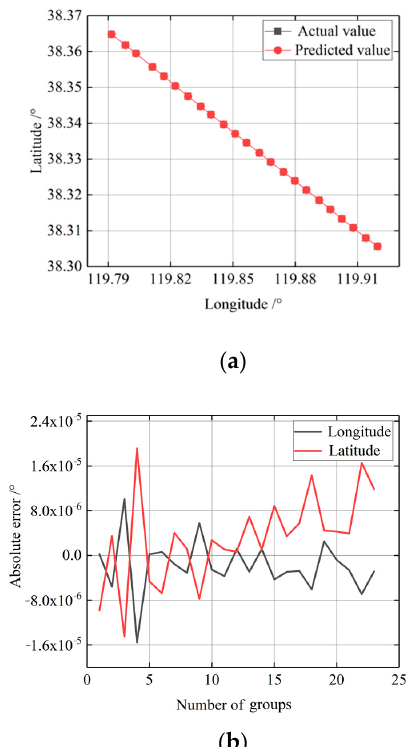
Figure 10. Prediction results of c-trajectory using the ACDE-SVR model. ( a ) Comparison of predicted and actual values of c-trajectory; ( b ) Longitude and latitude absolute error values of c-trajectory.